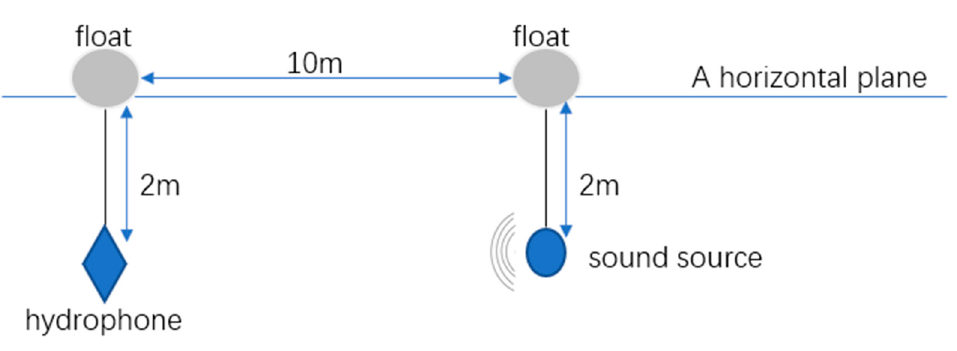
Figure 2. Signal acquisition